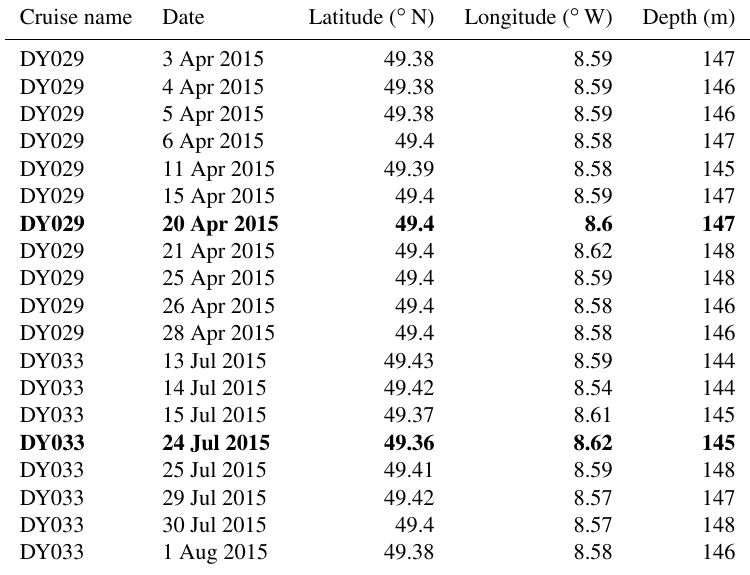
Table B1. List of relevant CTD casts for the CCS location from DY029 and DY033 cruises considering the date, location (latitude and longitude), and depth. CTD casts in bold are the ones chosen in this work to validate each model during spring and summer.